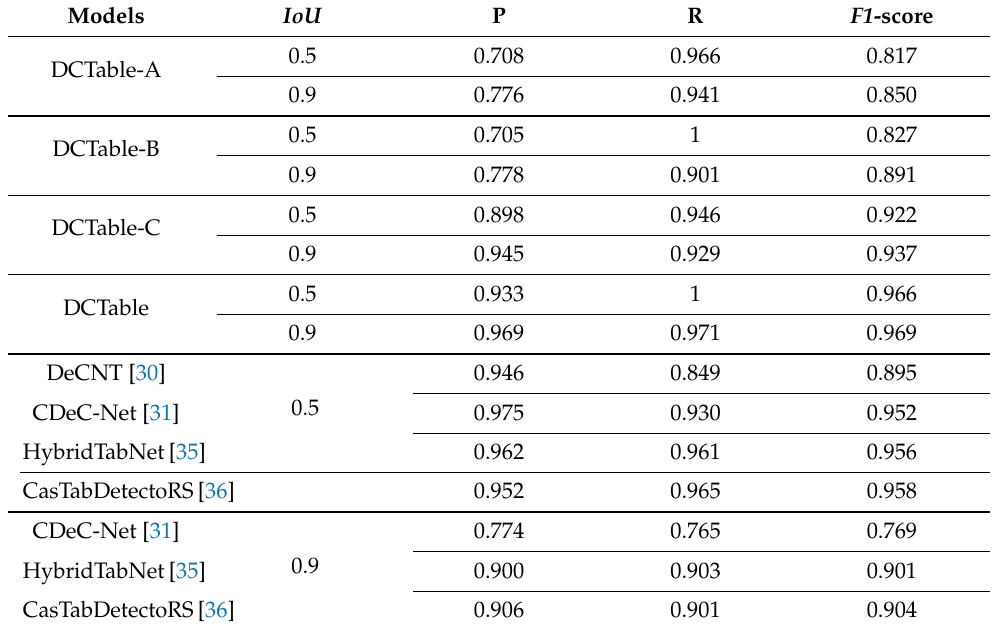
Table 3. Evaluation on Marmot.